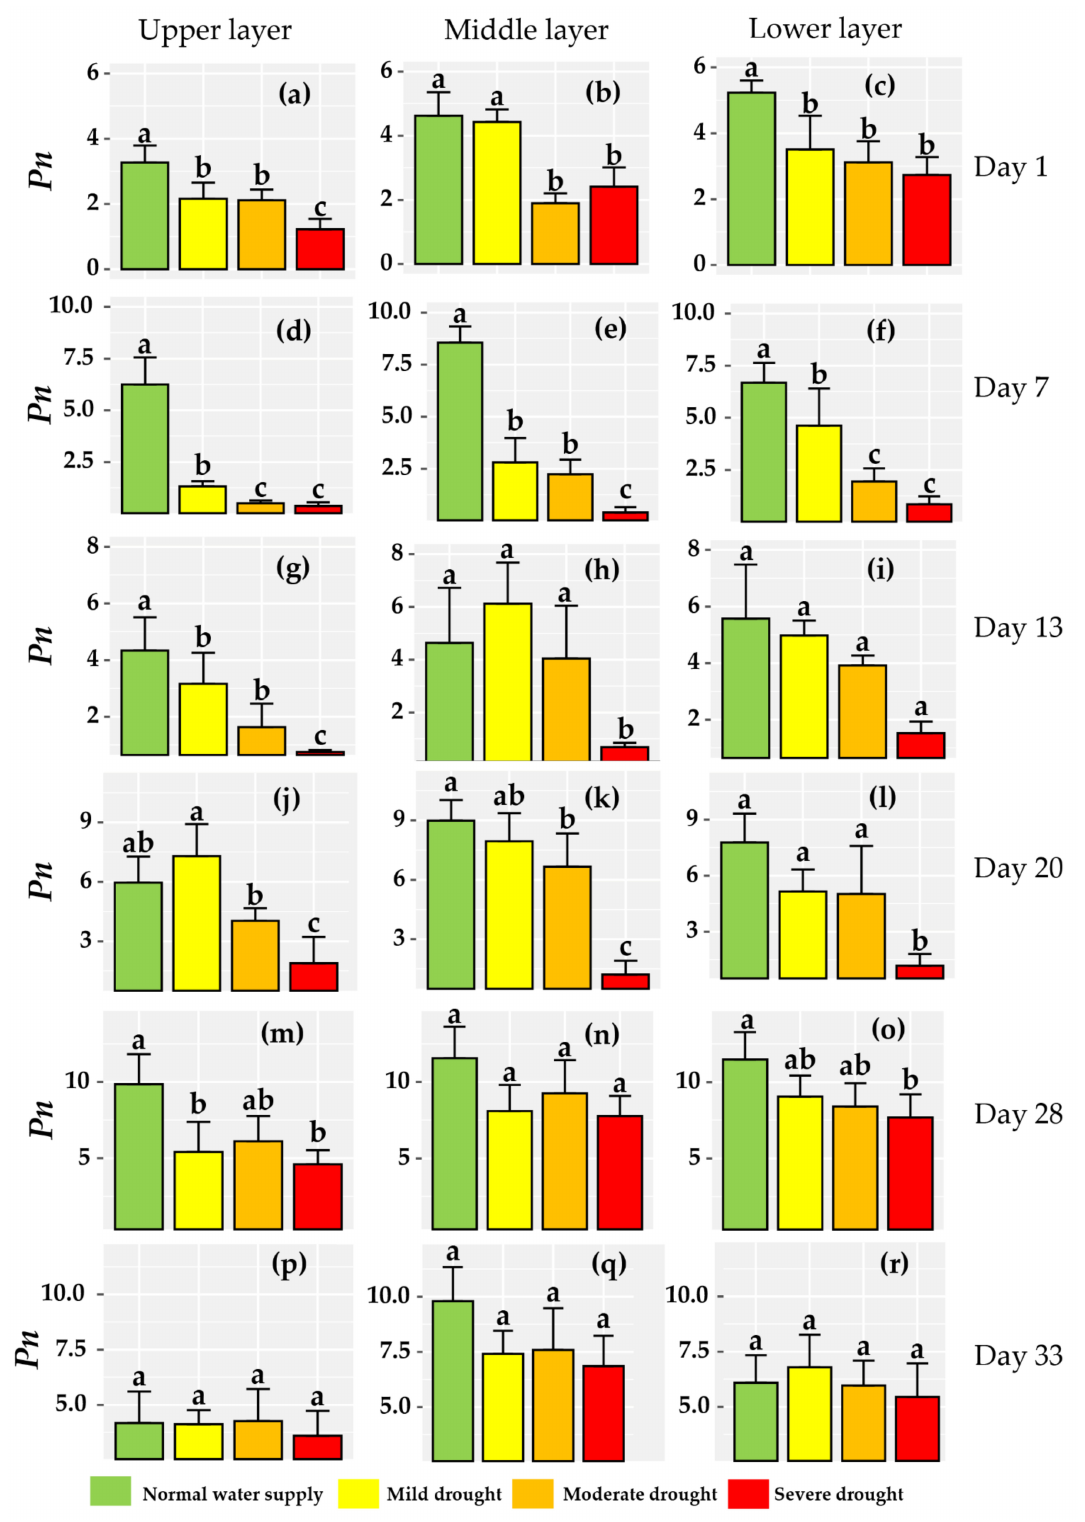
Figure 3. One-way ANOVA test results of photosynthetic CO 2 assimilation rate ( Pn , mol m − 2 s − 1 ) for the upper layer, middle layer, and lower layer of different water stresses in the drought treatment period (i.e., Days 1, 7, 13, and 20) and rewatering period (i.e., Days 28 and 33). The data are presented in the form of mean ± standard error, and significant differences are indicated by different letters in the same